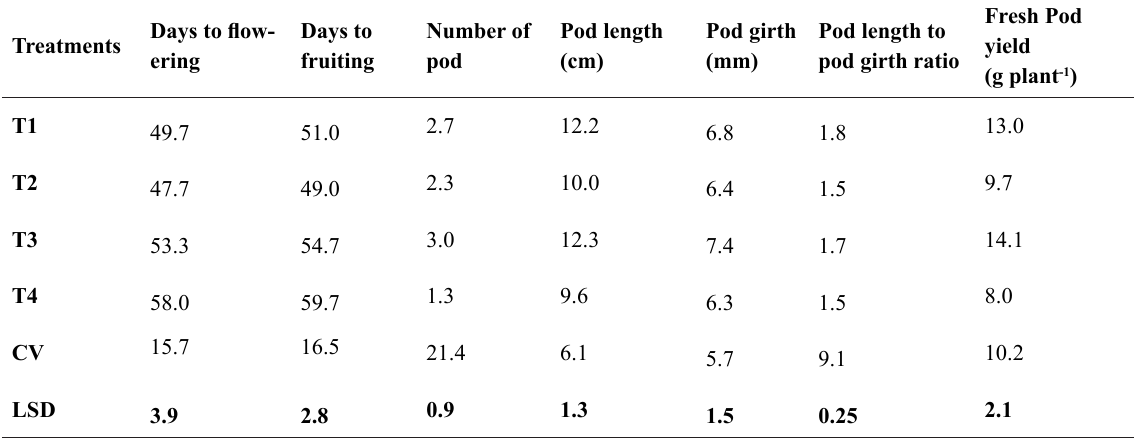
Table 5 Effect of manure application on reproductive and yield performance of okra Days to Treatments